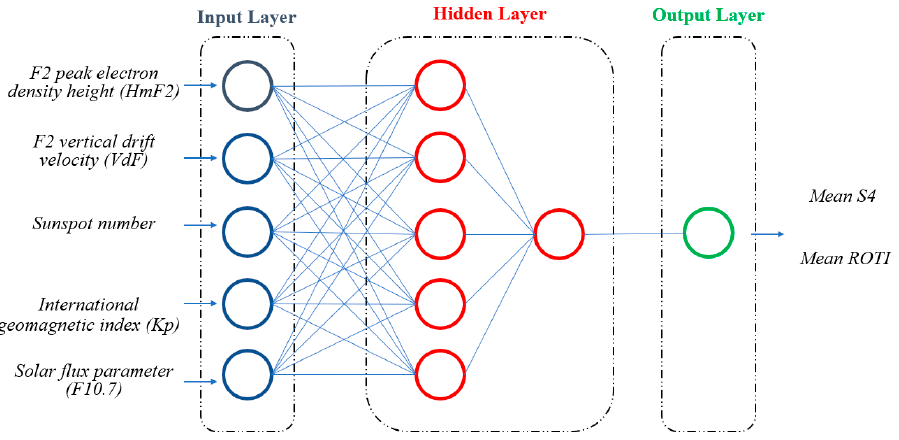
Figure 2. The architecture of the proposed neural network model for the prediction of ionospheric scintillation parameters (S4 and ROTI).